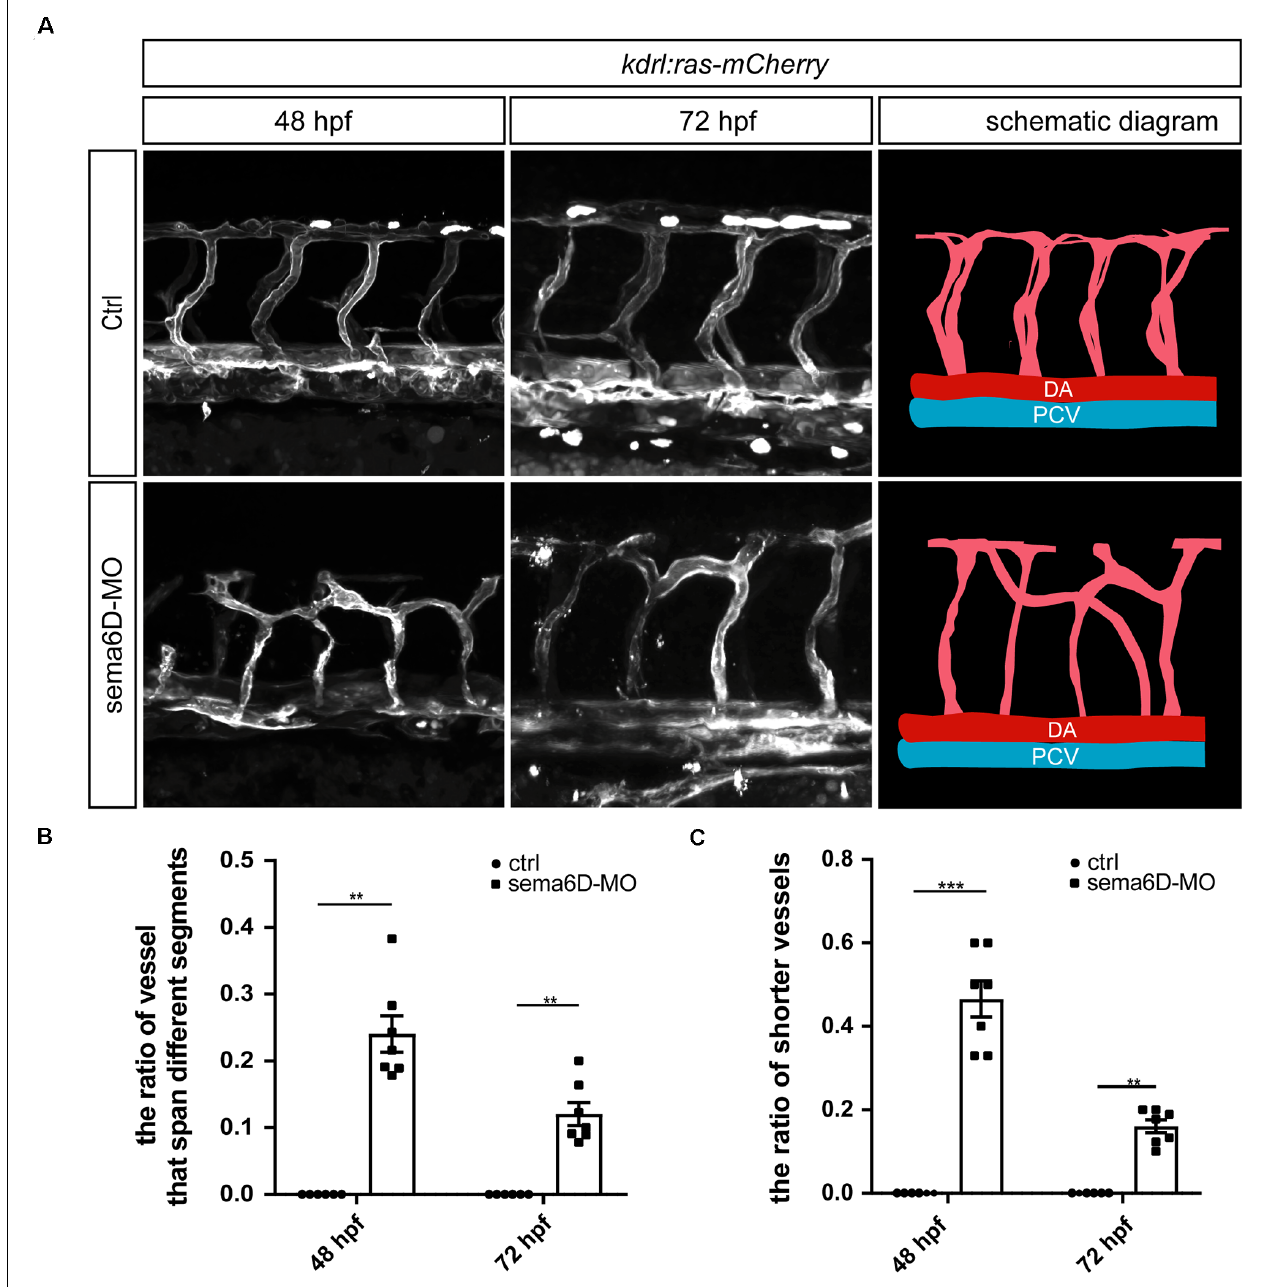
FIGURE 4 | Deficiency of sema6D caused aberrant vascular networks. (A) Confocal imaging analysis of ISVs in the control and sema6D -MO embryos at 48 and 72 hpf. (B) The statistical analysis of the ratio of vessels that span different segments in the control and sema6D morphants at 48 and 72 hpf ( n = 7). About 9–12 ISVs were used for statistics per zebrafish. Mann-Whitney test, P = 0.0012. Values with ** above the bars are significantly different ( P < 0.01). (C) The statistical analysis of the ratio of shorter vessels in the control and sema6D morphants at 48 and 72 hpf ( n = 7). About 9–12 ISVs were used for statistics per zebrafish. Mann-Whitney test, 48 hpf: P = 0.0006; 72 hpf: P = 0.0012. Values with ** and *** above the bars are significantly different ( P < 0.01 and P < 0.001,